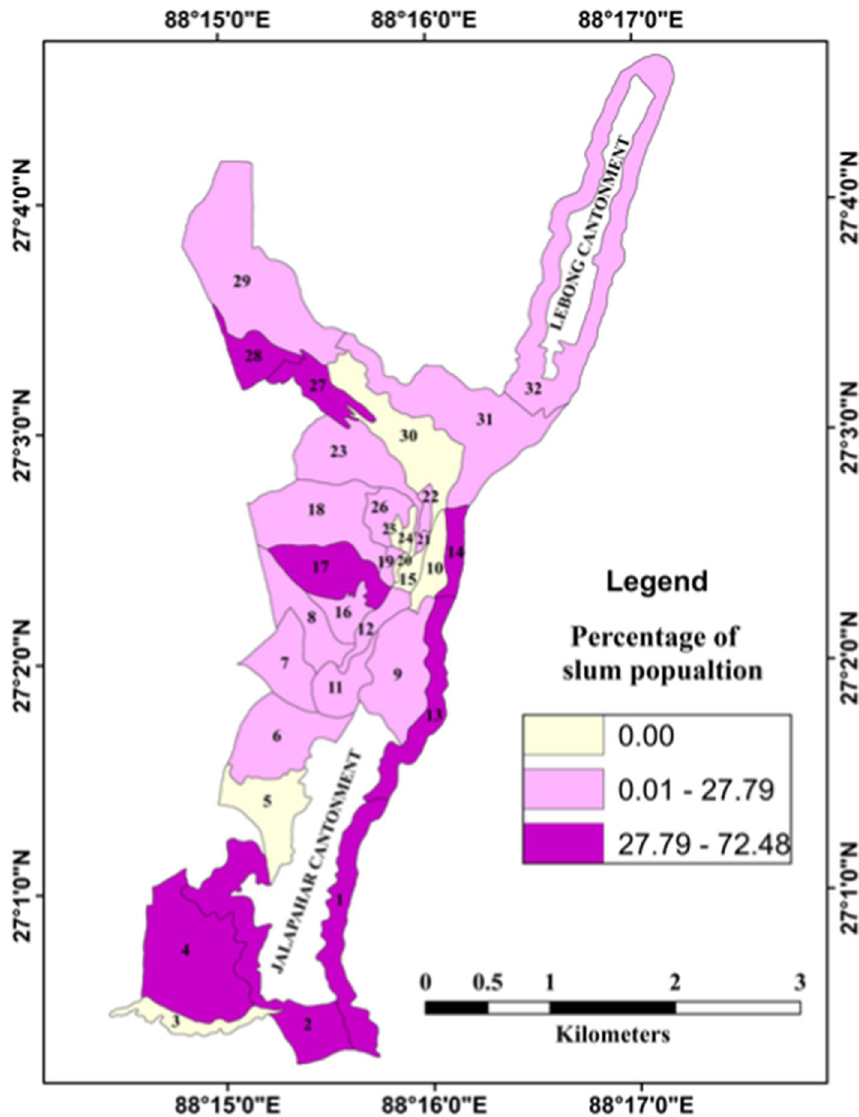
Fig. 6 Distribution of slum